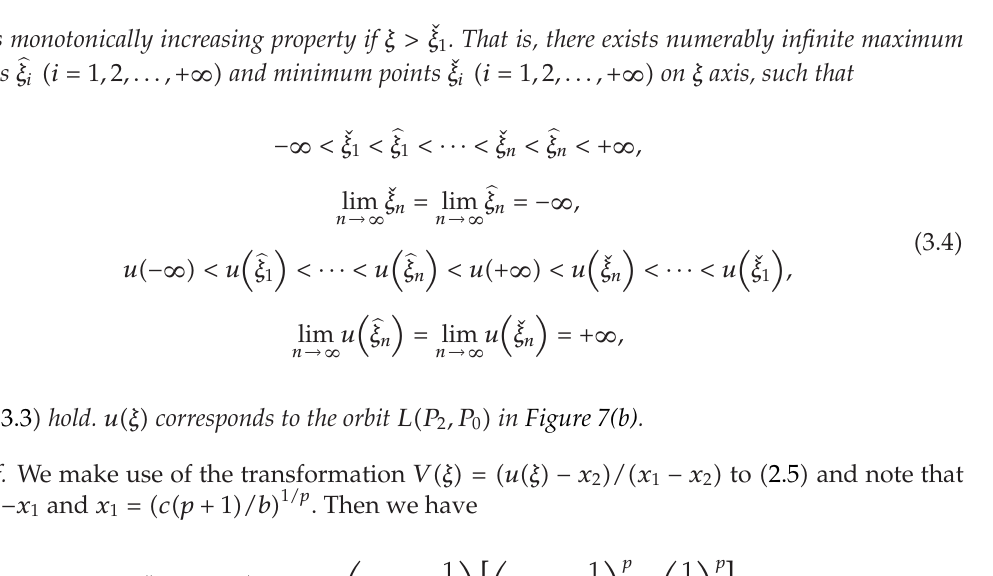
Figure 11: (cid:6) b < 0, c > 0 (cid:7)